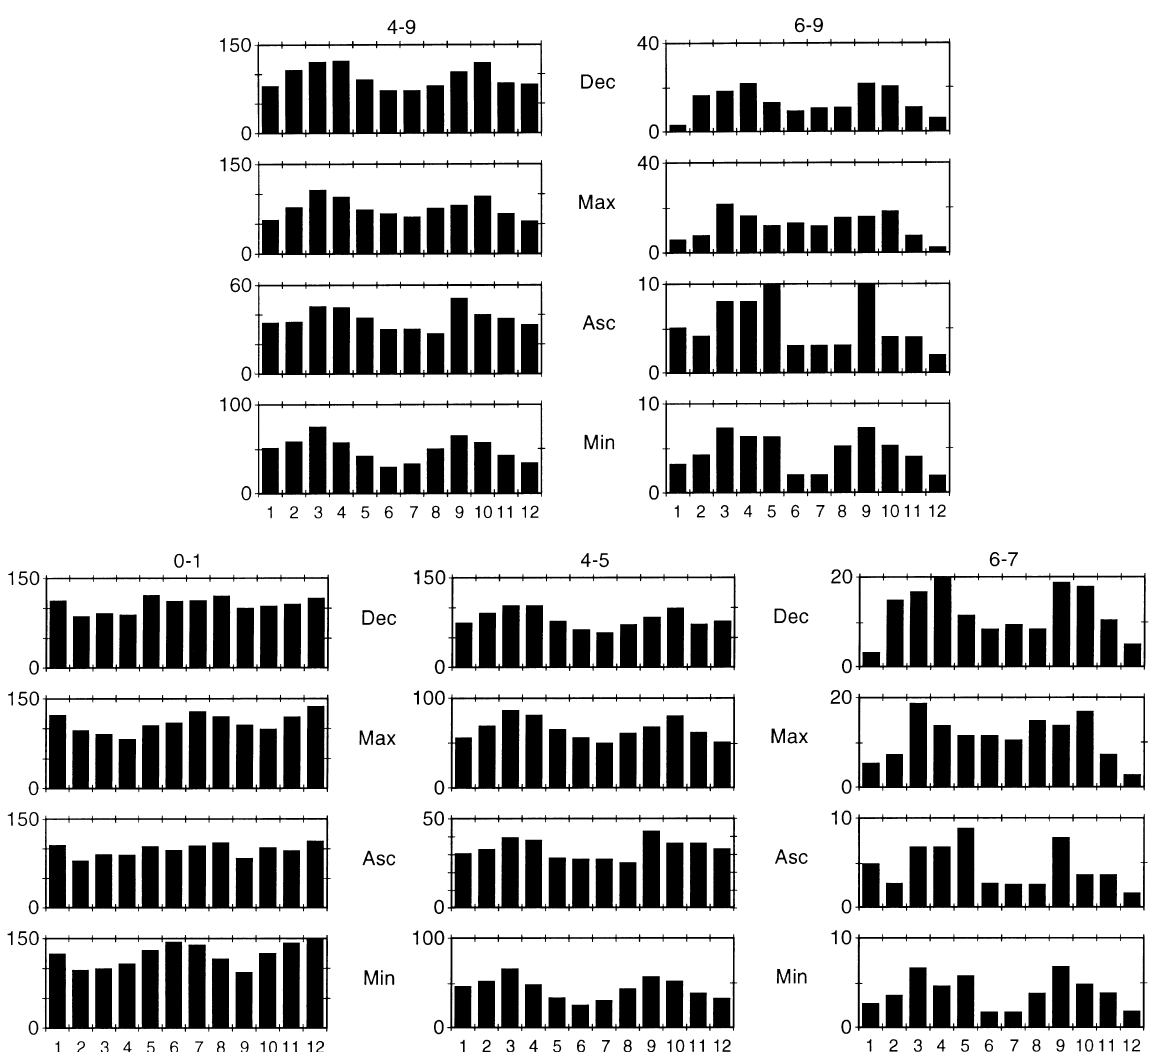
Fig. 3. Mean monthly occurrence frequencies of Kp index in di(cid:128)erent magnitude ranges as a function of the phase of the solar cycle: minimum ( Min ); ascending ( Asc ); maximum ( Max ); and declining (